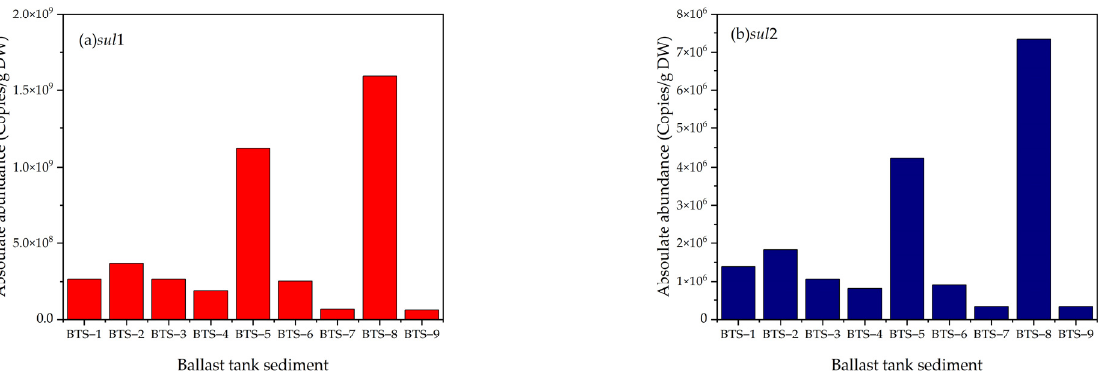
Figure 2. Absolute concentrations of ( a ) sul 1 and ( b ) sul 2 in ballast tank sediments (BTS − 1 to BTS − 9 refer to ballast tank sediment samples) [28].